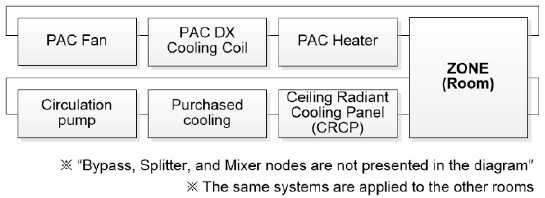
Figure 6. Flow chart representing the system configuration of the simulation model.